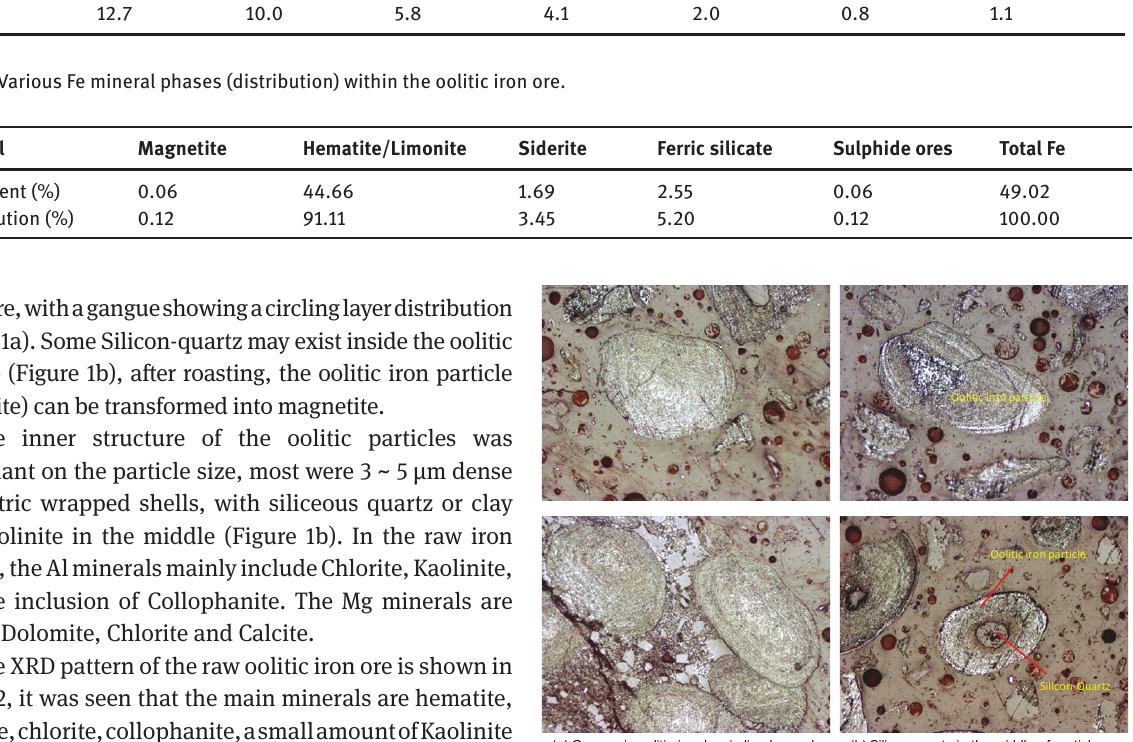
Table 3: Mineral component and its content in oolitic iron ore (%, ω ). Hematite Ankerite Chlorite Collophanite Kaolinite Quartz Pyrite